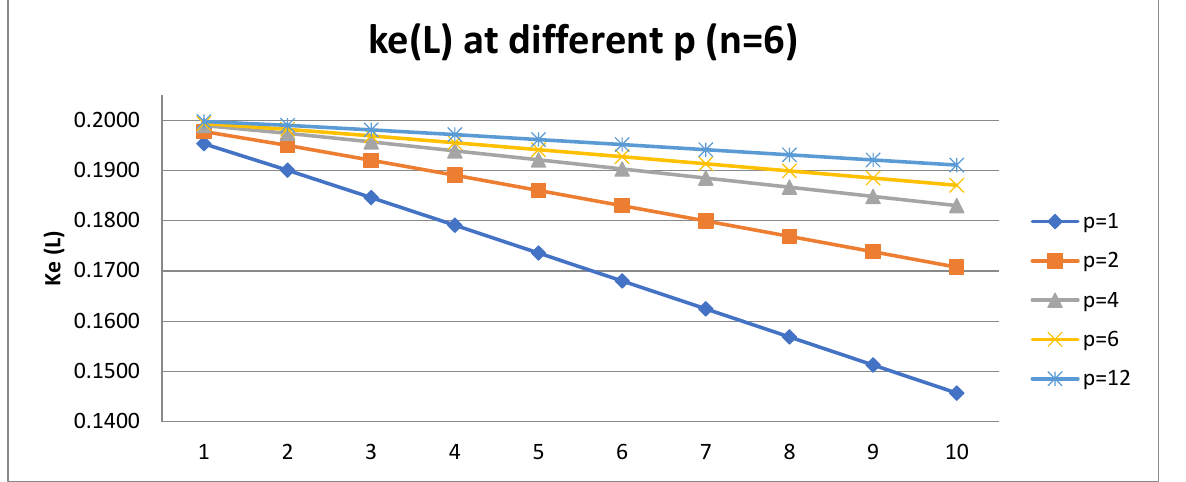
Figure 9. The dependence of the equity cost ( ke ) on the leverage level (L) of a six-year-old company for advance profit tax payments with frequencies of p = 1, 2, 4, 6 and 12. The comparison of the dependence of the WACC on the leverage level ( L ) of a six-year-old company for profit tax payments that were (1) made at the end of the finan- cial period and (2) made at the beginning of the financial period (i.e., advance payments) with frequencies of p = 2, 4, 6 and 12 is shown in Figure 10.